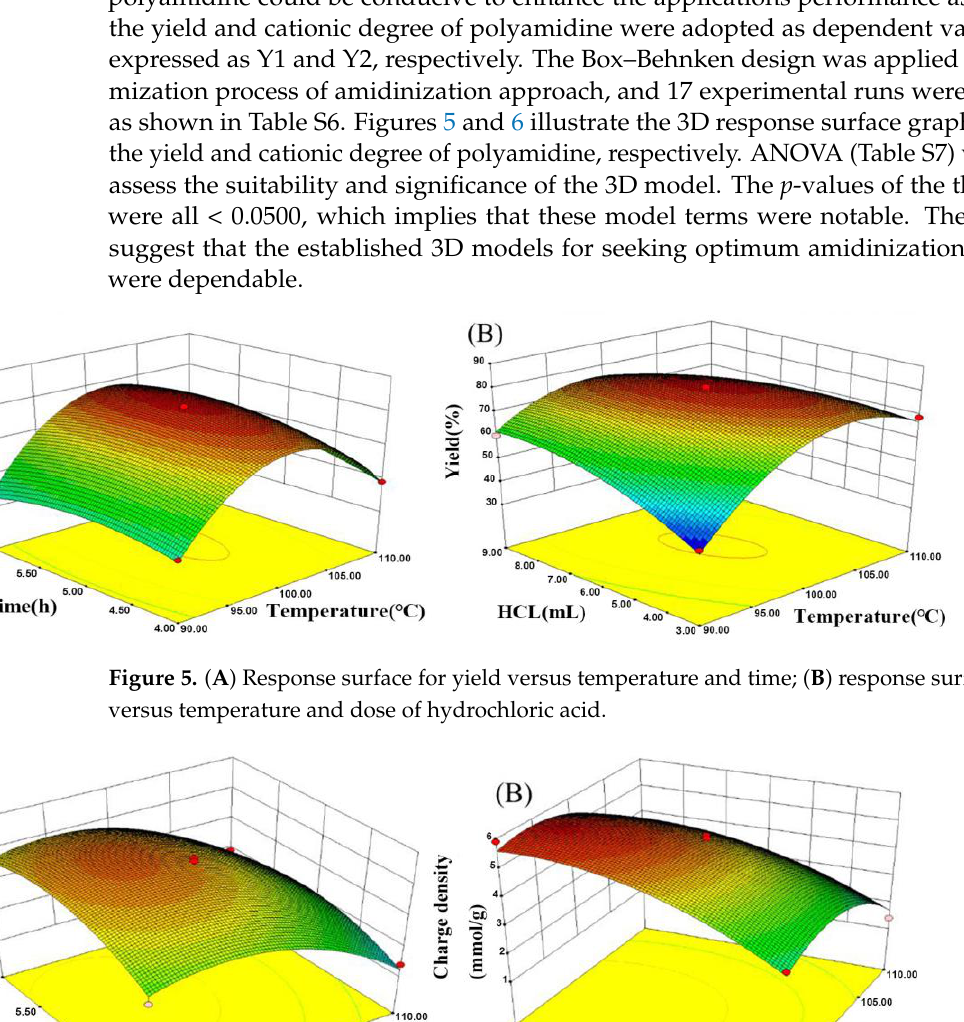
6 of 11 Figure 4. FT-IR spectrum of PNVF-co-PAN.